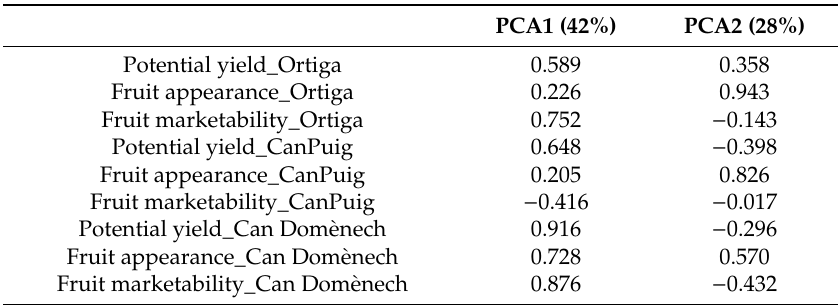
Table 4. Correlation coe ffi cients between farmers’ evaluations and the first and second principal components in the Ortiga, Can Puig, and Can Dom è nech